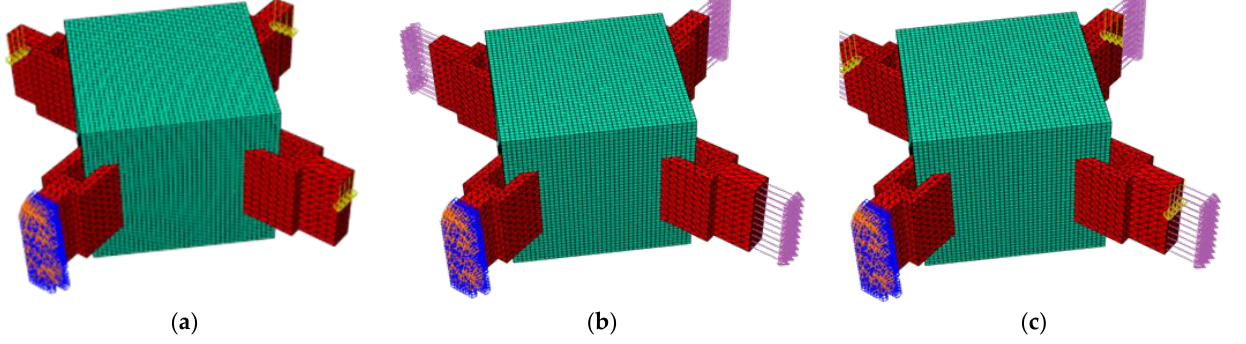
Figure 5. Schematic diagram of finite element application of different load cases (pink arrows are axial forces, yellow arrows are shear forces, orange and blue ends are where the boundary condi- tions are applied, and the green part is design domain): ( a ) shear load; ( b ) axial load; ( c ) combined load.